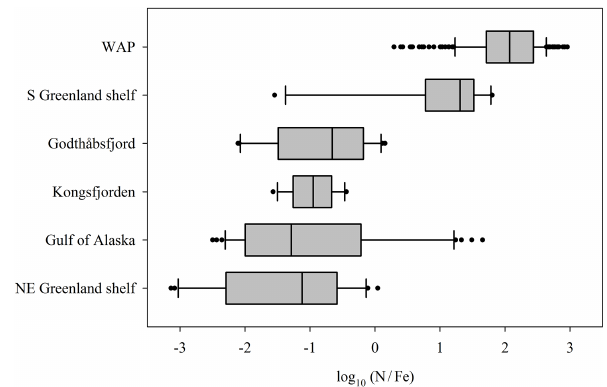
Figure 7. Variations in the ratio of dissolved NO 3 and Fe in surface waters ( < 20m) adjacent to glaciated regions: whiskers show the 10th and 90th percentiles; bars shows the median, 25th percentile and 75th percentile; and dots show all outliers. Data from the west- ern Antarctic Peninsula (WAP, Annett et al., 2017; Ducklow et al., 2017), the south Greenland shelf (Achterberg et al., 2018; Tonnard et al., 2020), Godthåbsfjord (Hopwood et al., 2016), Kongsfjorden (Hopwood et al., 2017), the Gulf of Alaska (Lippiatt et al., 2010) and the NE Greenland shelf (Hopwood et al., 2018). For Kongs- fjorden, NO 3 and Fe data were interpolated using the NO 3 –salinity